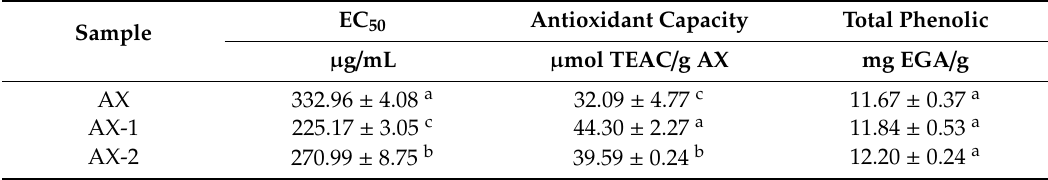
Table 2. Antioxidant capacity and total phenolic content of